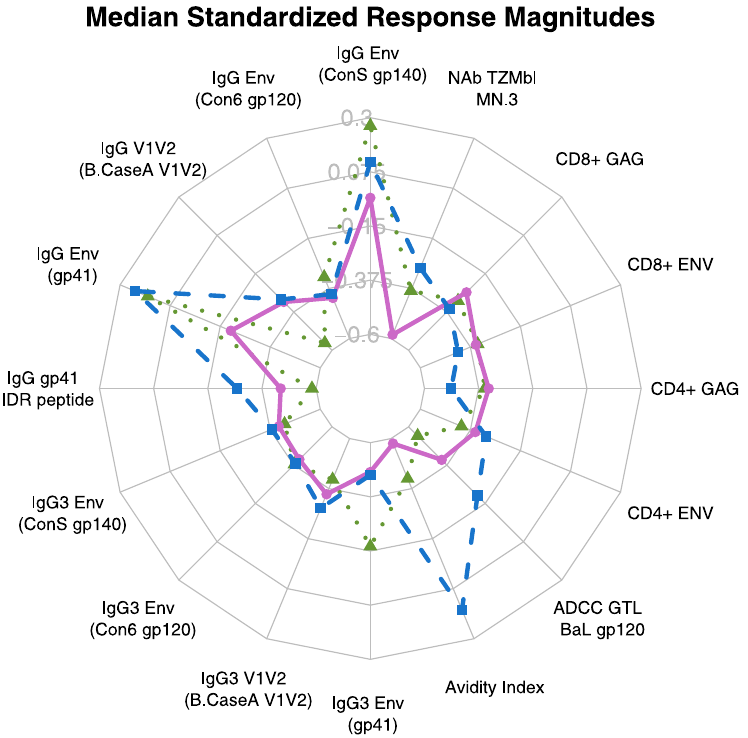
Fig 8. Radar plot of peak antibody-mediated and cellular immune responses by vaccine regimen. (A) Response rates of each assay readout. (B) Responsemagnitudes of each assay readout. DgDgM_Mrefers to immune responses after the last MVA in the DgDgM_Mgroup; DgDgMM and DgDgMM_M refer to immune responses after the 2nd and 3rd MVA in DgDgMM_Mgroup, respectively.